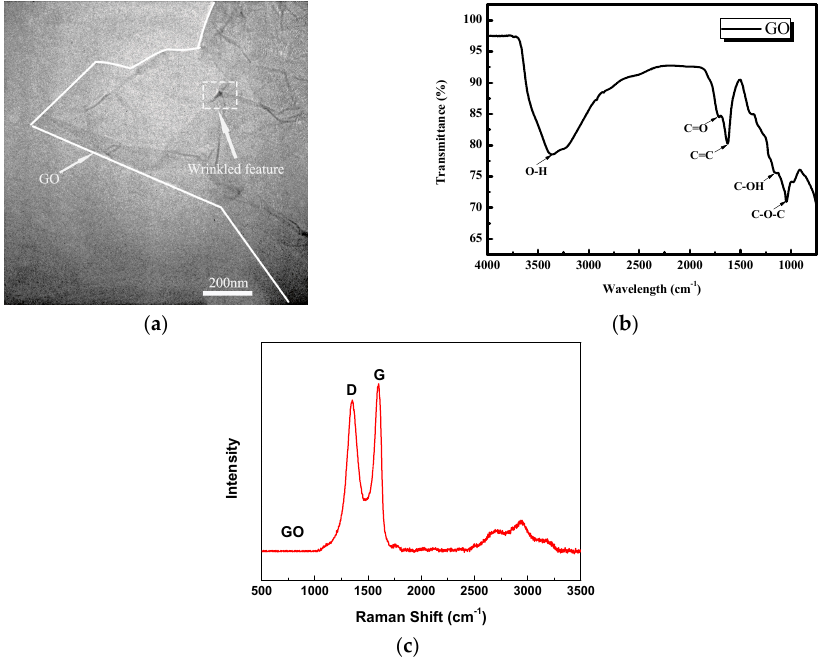
Figure 1. Characterization of graphene oxide (GO) by ( a ) Transmission Electron Microscopy (TEM) Image; ( b ) Fourier transform infrared spectroscopy (FT-IR) transmittance spectra; ( c ) Raman spectra.